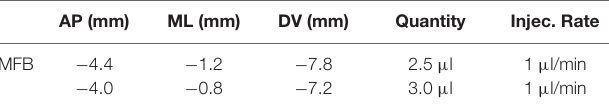
TABLE 1 | Lesion coordinates in MFB, quantity of 6-OHDA per coordinate and injection